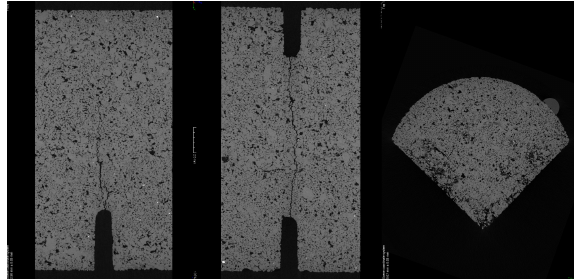
Figure 4. Visualization of damaged sample in three perpendicular planes based on the reconstructed micro- CT data corresponding to displacement 320 µ